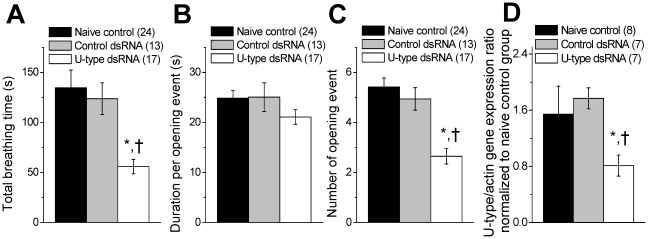
Acute U-type dsRNA knockdown suppresses aerial respiratory behaviour
in adult L. stagnalis in vivo.Summary of the (A) total breathing time, (B) duration per opening event,
and (C) number of opening events for naïve control
(n = 24), control dsRNA
(n = 13), and U-type dsRNA injected snails
(n = 17). U-type dsRNA injected snails only showed
significant reduction in total breathing time (55.82±7.13 s) and
number of opening events (2.65±0.31) when compared to naive
control (total breathing time of 134.60±17.76 s and
5.42±0.36 opening events) and control dsRNA (total breathing time
of 123.77±15.82 s and 4.94±0.45 opening events). Average
opening duration for U-type dsRNA (21.09±1.46 s) injected group
is not significantly different from the naive control (24.85±1.51
s) and control dsRNA (25.05±2.86 s) injected snails. (D) Summary
of real-time PCR performed following behavior experiments. Ganglia from
U-type dsRNA injected snails that showed decrease in aerial respiratory
behavior were used to confirm U-type channel knockdown with real-time
qPCR. The result was then compared with that of naive control and
control dsRNA groups. Beta-actin control gene was used for ratiometric
analysis of U-type mRNA expression level. * and † indicate
significant difference (P<0.05) from the naïve control and
control dsRNA treatments, respectively.